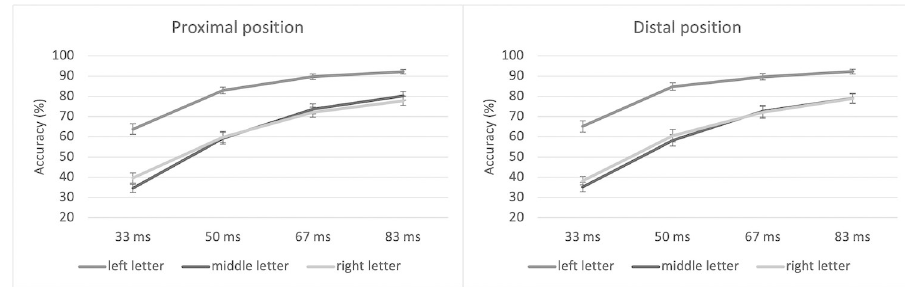
Fig 2. Accuracy by condition. Accuracy (in percentages) data in the proximal and distal conditions. Error bars represent 95% confidence